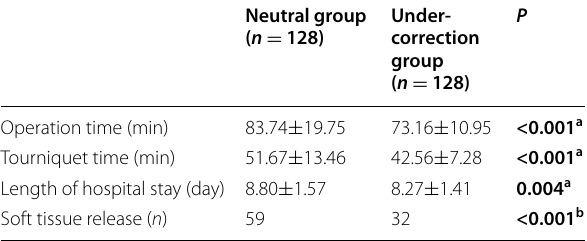
a stands for Student t -test b stands for chi-square test; data are recorded as number or mean